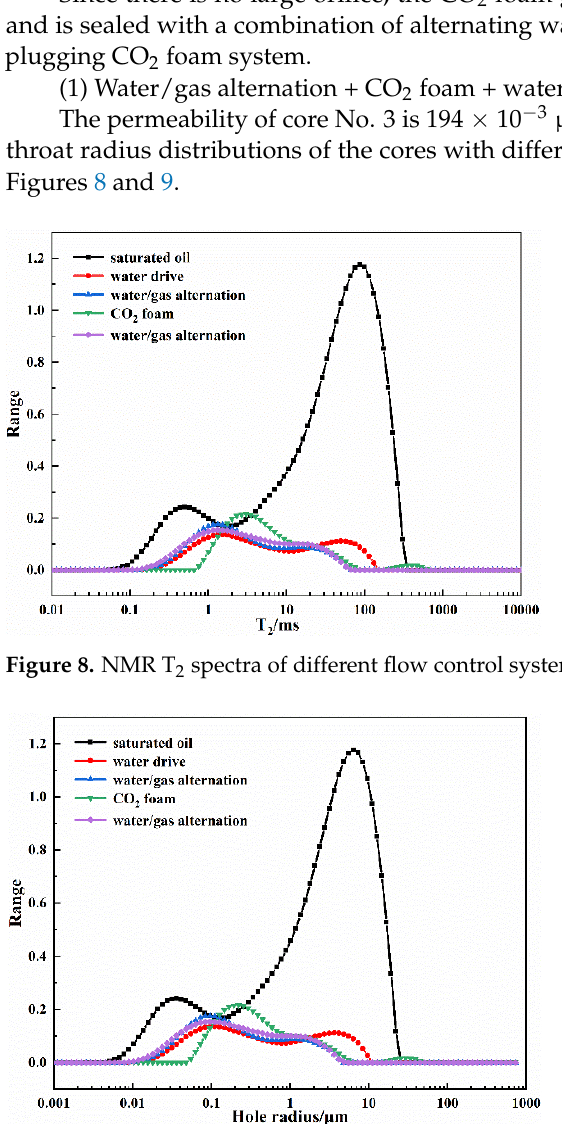
Figure 9. Pore throat radius distribution of different flow control systems in core No. 3.